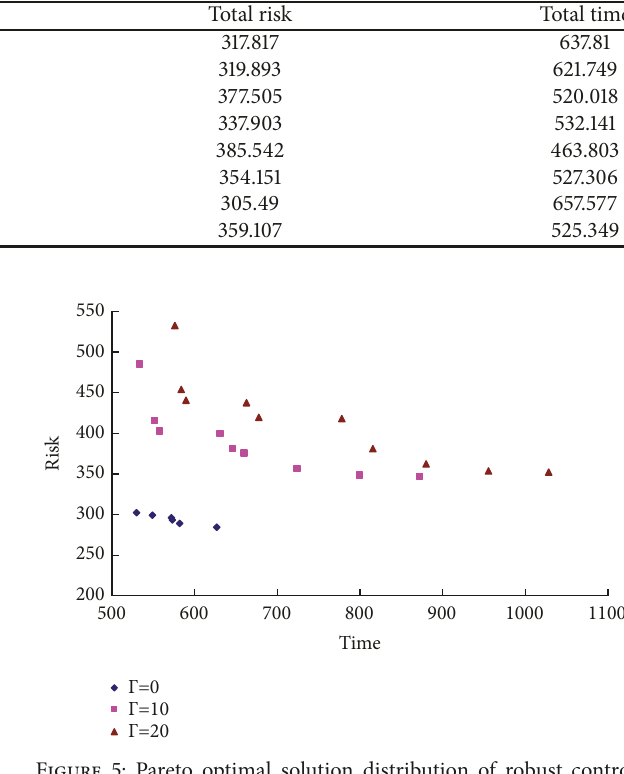
Figure 4: Pareto optimal solution distribution of robust control parameters Γ =0, Γ =10, and Γ =20 for distribution center a.